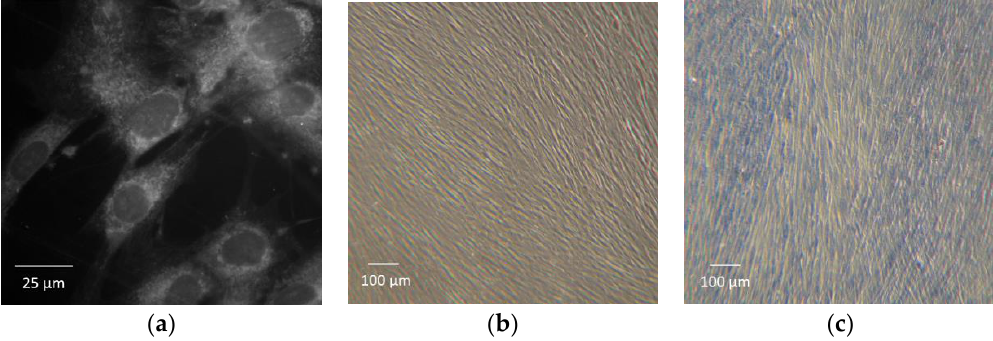
Figure 5. Image of vital fibroblasts (HFFF2) in: ( a ) detailed view and ( b ) lower magnification for demonstration of the typical elongated shape; ( c ) Image of dead fibroblasts dyed with trypan blue at lower magnification (10×).